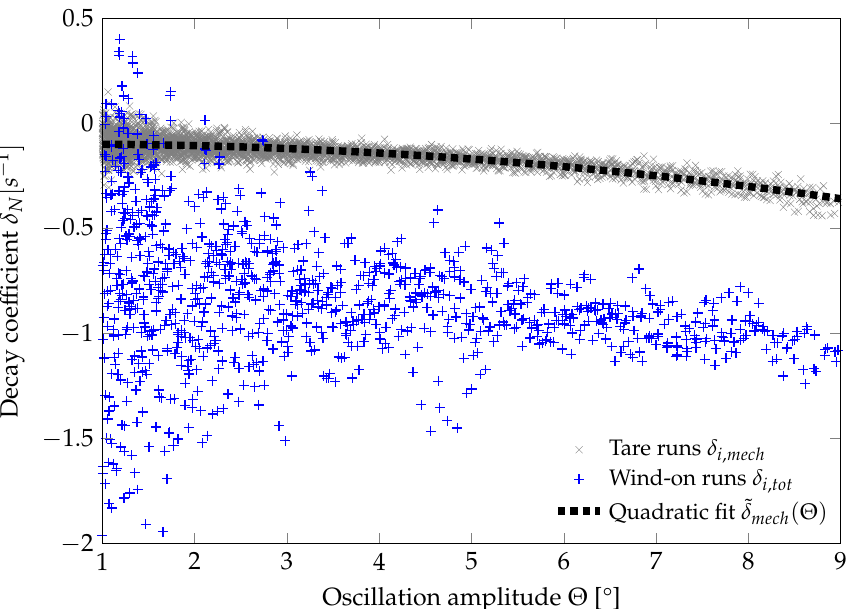
Figure 5. δ mech (x) and δ tot (+) measurements for the ANSR at Mach